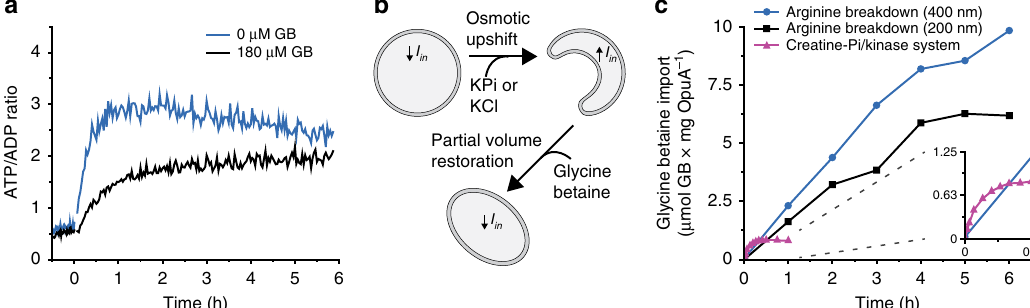
Fig. 5 ATP/ADP homeostasis and long-term transport. The internal composition of the vesicles at the start of the experiment is given in Fig. 2a (enzymes) and Table 2 (ions, metabolites) and the preparation of vesicles is given in protocol A1, unless speci fi ed otherwise. a Effect of external glycine betaine (GB) on the ATP/ADP ratio measured by PercevalHR (protocol B3) in unshocked arginine-metabolizing vesicles (made with 13 mol% of DOPG; protocol A7), in the presence (black trace) and absence (blue trace) of 180 µ M glycine betaine, added at t = − 0.5 h. Five millimolar arginine was added at t = 0 ( n = 2). b Schematic representation of the effect of osmotic upshift and partial volume restoration through glycine betaine uptake are shown. c Comparison of glycine betaine uptake (protocol B1) driven by ATP formed in the arginine breakdown pathway from 400 nm extruded vesicles (blue circles), 200 nm extruded vesicles (protocol A4; black squares), and the creatine-phosphate/kinase system (protocol A5; pink triangles) ( n =